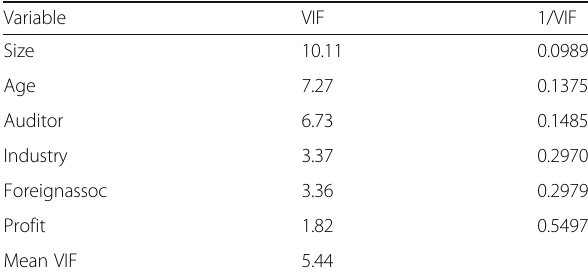
Table 5 Variance Inflation Factor